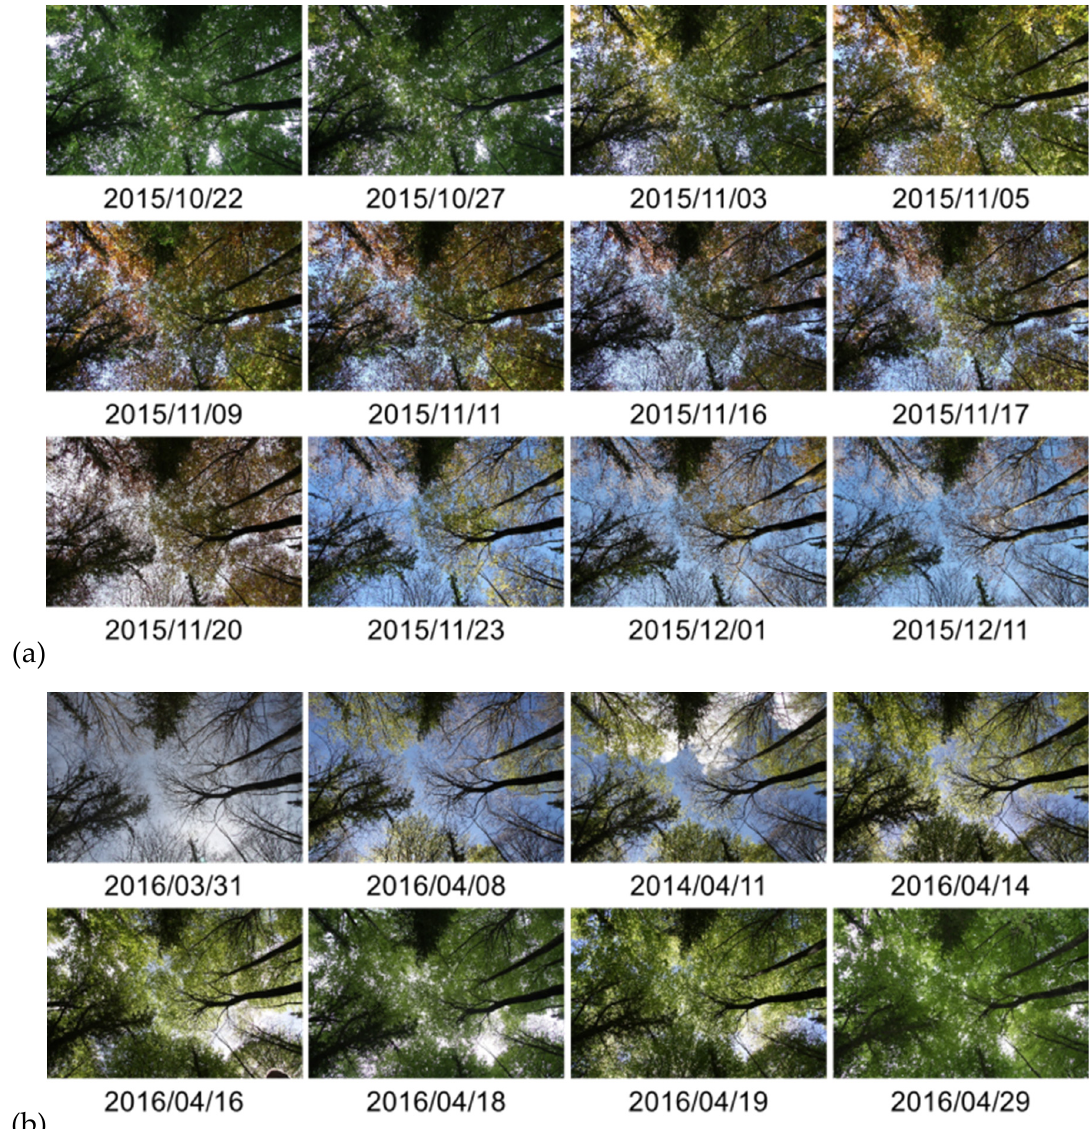
Figure 5. Vegetation observed from a camera located at the instrument’s position looking to the zenith during (a) the fall season and (b) during the spring